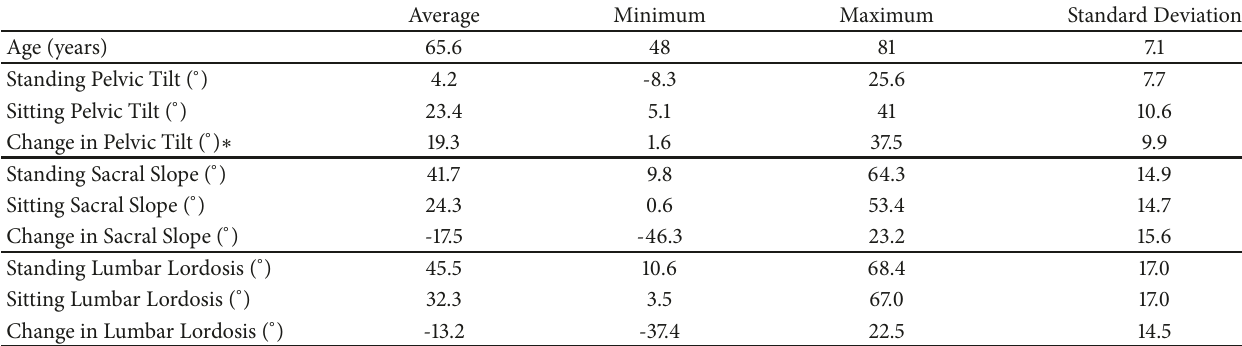
Table 3: Age and spinopelvic measurements of the 24 subjects included in this study. ∗ Significant difference between standing and sitting pelvic tilts (p <